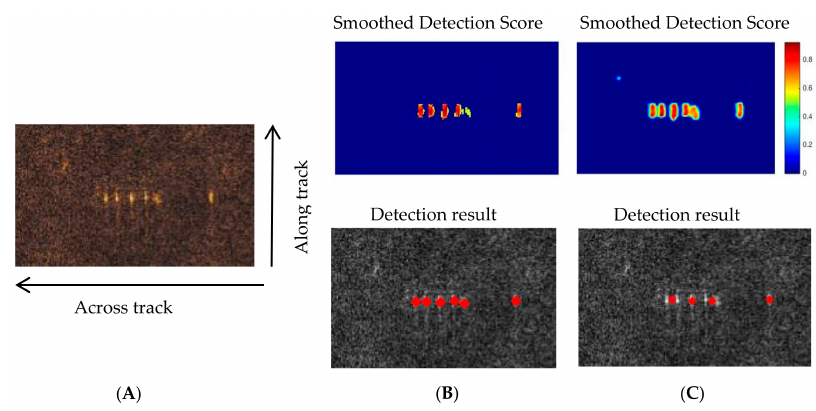
Figure 13. ( A ) The SSS image of multi-target with no shadows, and the image was collected by Synthetic Aperture Sonar (SAS) developed by http://www.sz-soundtech.com/. ( B ) The detection results by the NS + DM. ( C ) The detection results by the Traditional